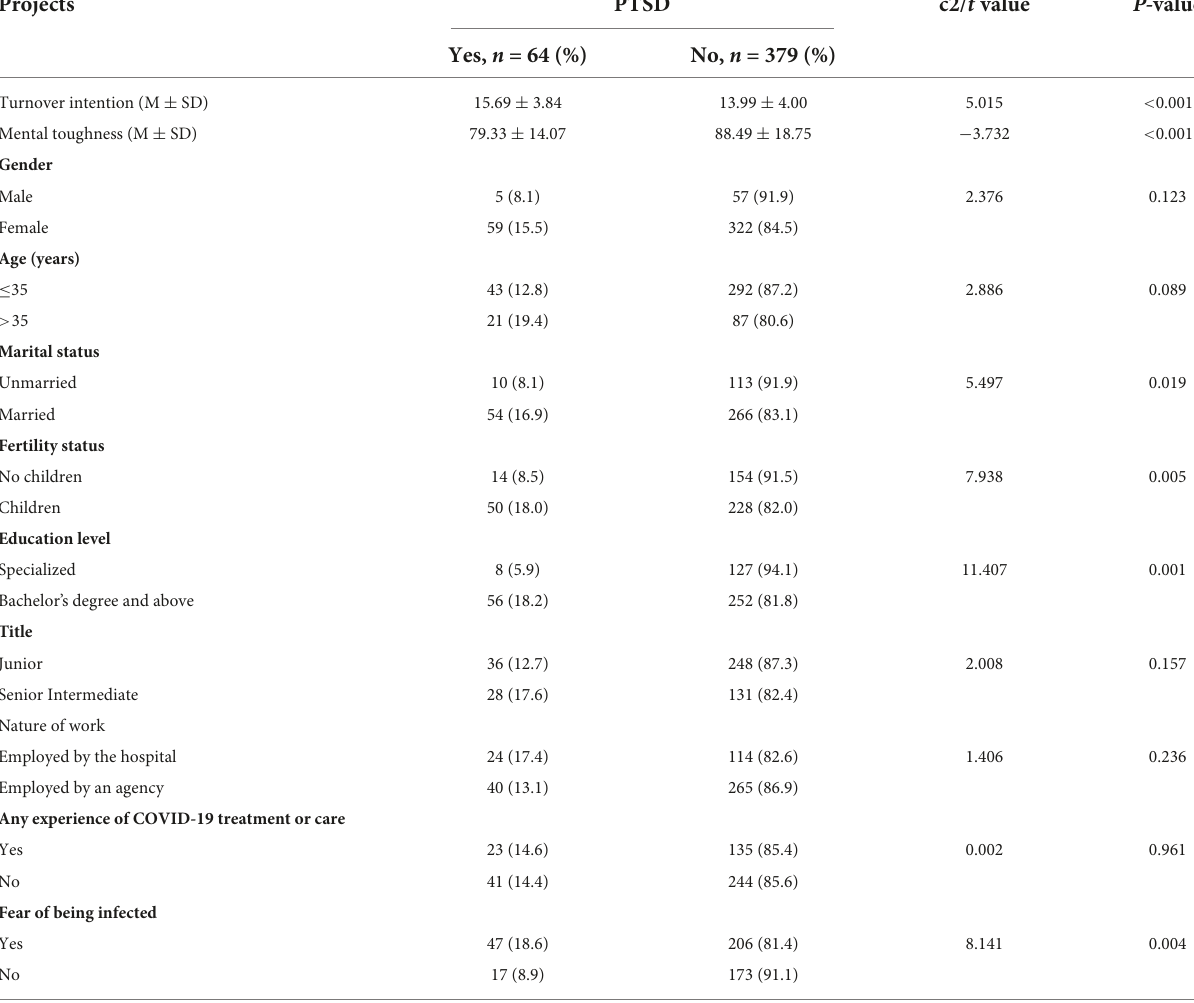
TABLE 2 Correlation analysis of psychological resilience scores with insomnia severity and general information (M ± SD, n = 443). Projects